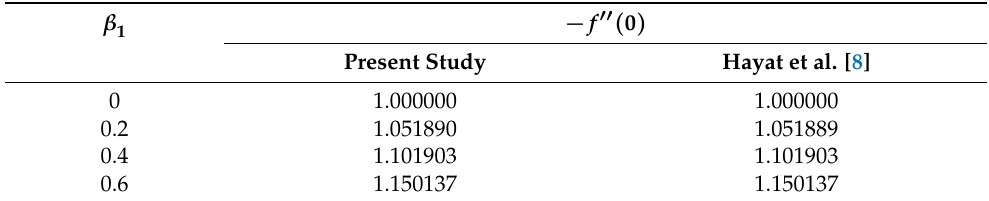
Table 2. Comparison on the values of − f (cid:48)(cid:48) ( 0 ) when φ = 0, λ = 1, S = 0, K = 0 and β 2 = β 3 = 0. − f (cid:48)(cid:48) ( 0 ) β 1 Present Study Hayat et al. [8] 0